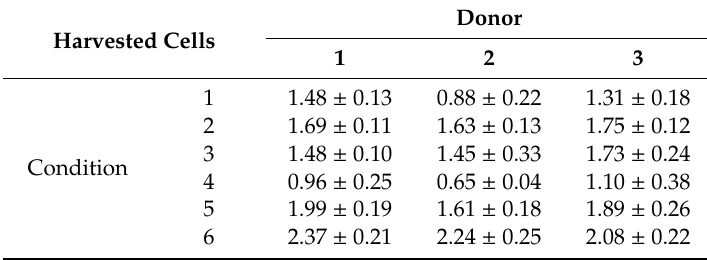
Figure 4. Lactate concentration over time (days) for the results of donor 1, condition 5 and triplicate 1. Table 2. Total amount of cells harvested after the cell culture expansion, which is averaged over the triplicates for each donor and condition (100,000 cells).